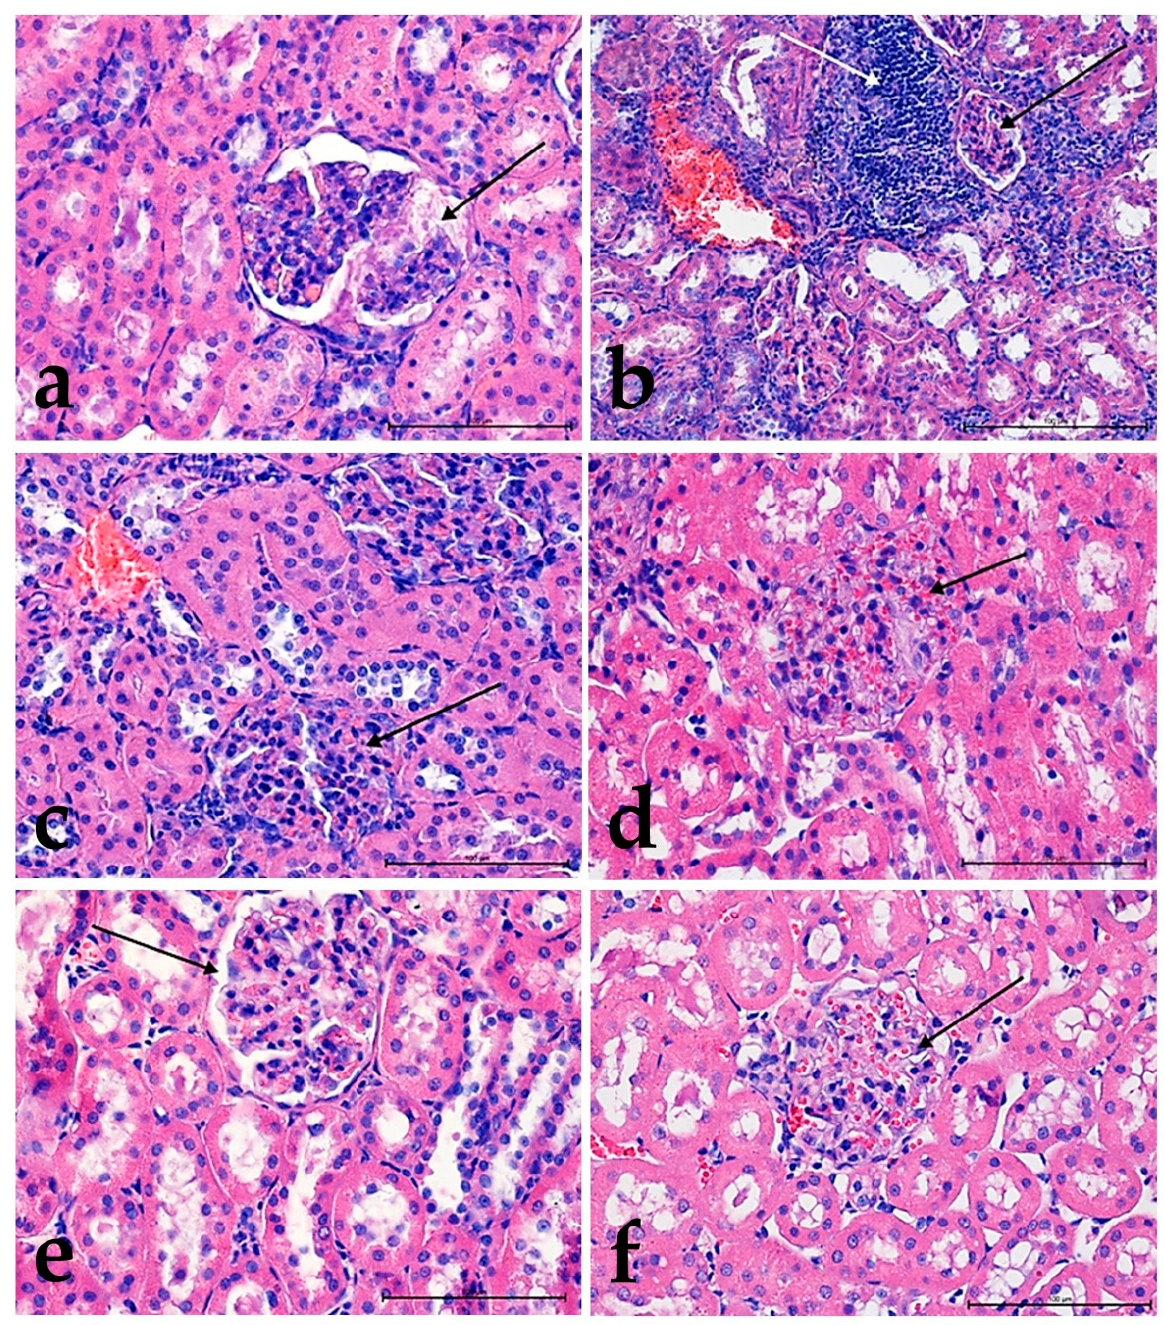
Figure 3. The changes in the structure of the kidneys in groups: IV ( a ), IVa ( b ), V ( c ), Va ( d ), VI ( e ), and VIa ( f ). A glomerulus with different urine and blood content (black arrow). The massive lymphocyte infiltration around the glomerulus in group IVa ( b ) (white arrow) H&E staining. Mag. 400×. Bar scale 100 µm.